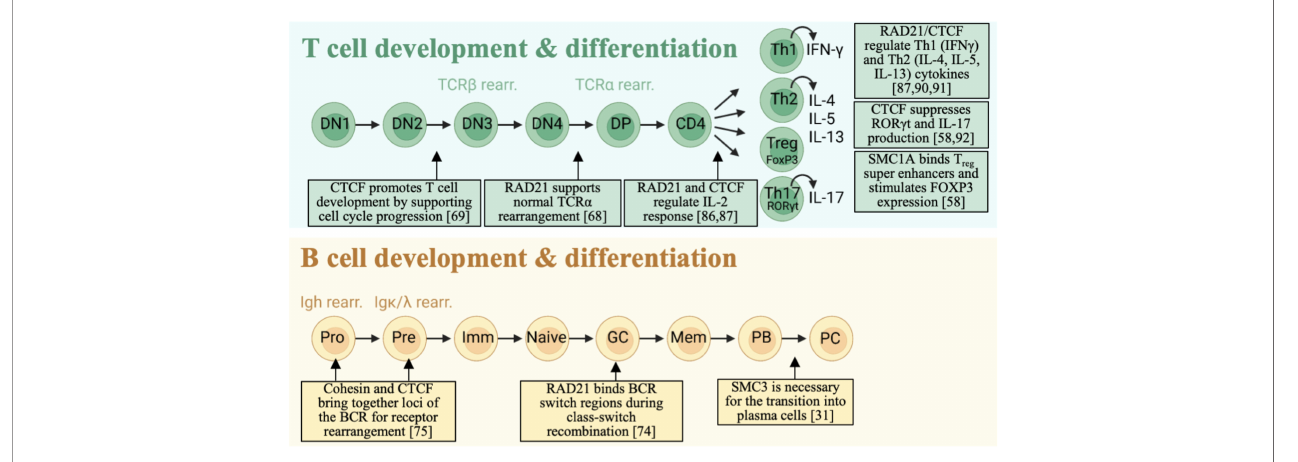
FIGURE 2 | Cohesin complex involvement in T and B cell development. Cohesin-CTCF complex is important for successful transition through lymphocyte developmental stages. RAD21 and CTCF ensure proper TCR rearrangement by organizing distant V and J segments into close interacting networks. In B cells, RAD21 and SMC3 bind to speci fi c BCR loci and regulate